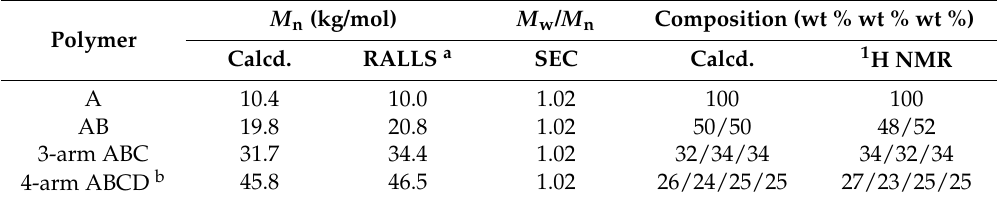
Table 1. Characterization results of ( μ -SP)s synthesized by the iterative methodology. Polymer